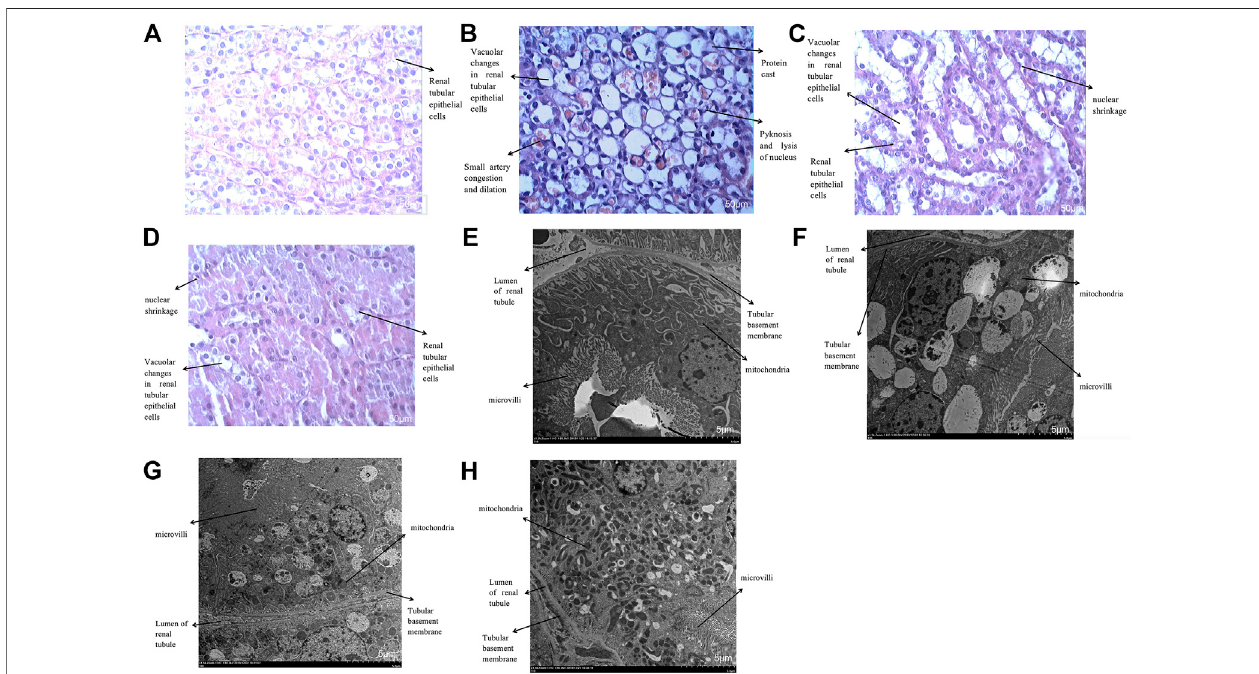
FIGURE 14 | (A – D) : Histological changes of four groups under optical microscope (Enlarge the picture to 400x). (A) : Haematoxylin staining of rabbit kidney in the control group; (B) : Haematoxylin staining of rabbit kidney in the contrast group; (C) : Haematoxylin staining of rabbit kidney in the hydration group; (D) : Haematoxylin staining of rabbit kidney in the nano liposome group. (E – H) : Histological changes of four groups under electron microscope (Enlarge the picture to 1500 × 5 µm). (E) : Ultrastructure of rabbit kidney in the control group; (F) : Ultrastructure of rabbit kidney in the contrast group; (G) : Ultrastructure of rabbit kidney in the hydration group; (H) : Ultrastructure of rabbit kidney in the nano liposome